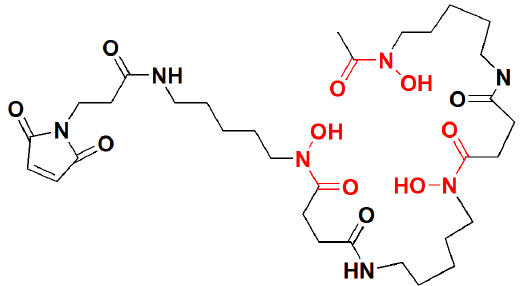
Figure 1. Structure of maleimide-derivatized desferrioxamine B (DFO).